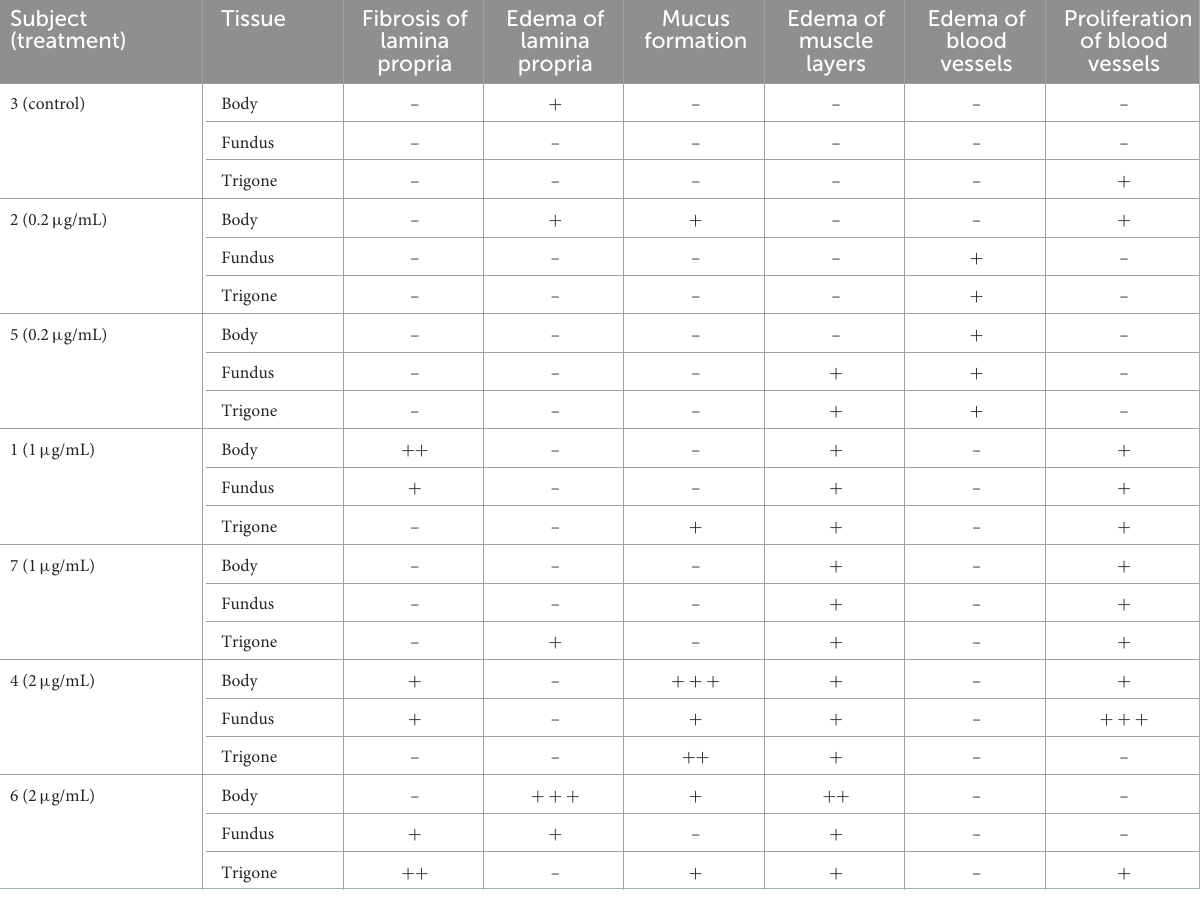
TABLE 2 Histopathological analysis of the lamina propria, muscular layers, and blood vessels of the urinary bladder of cats 14 days after treatment with 0 (control), 0.2, 1, and 2 µ g/mL of RTX instilled into the urinary